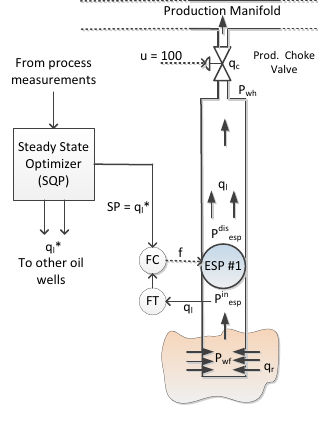
Figure 11: Optimal control structure with a single PI